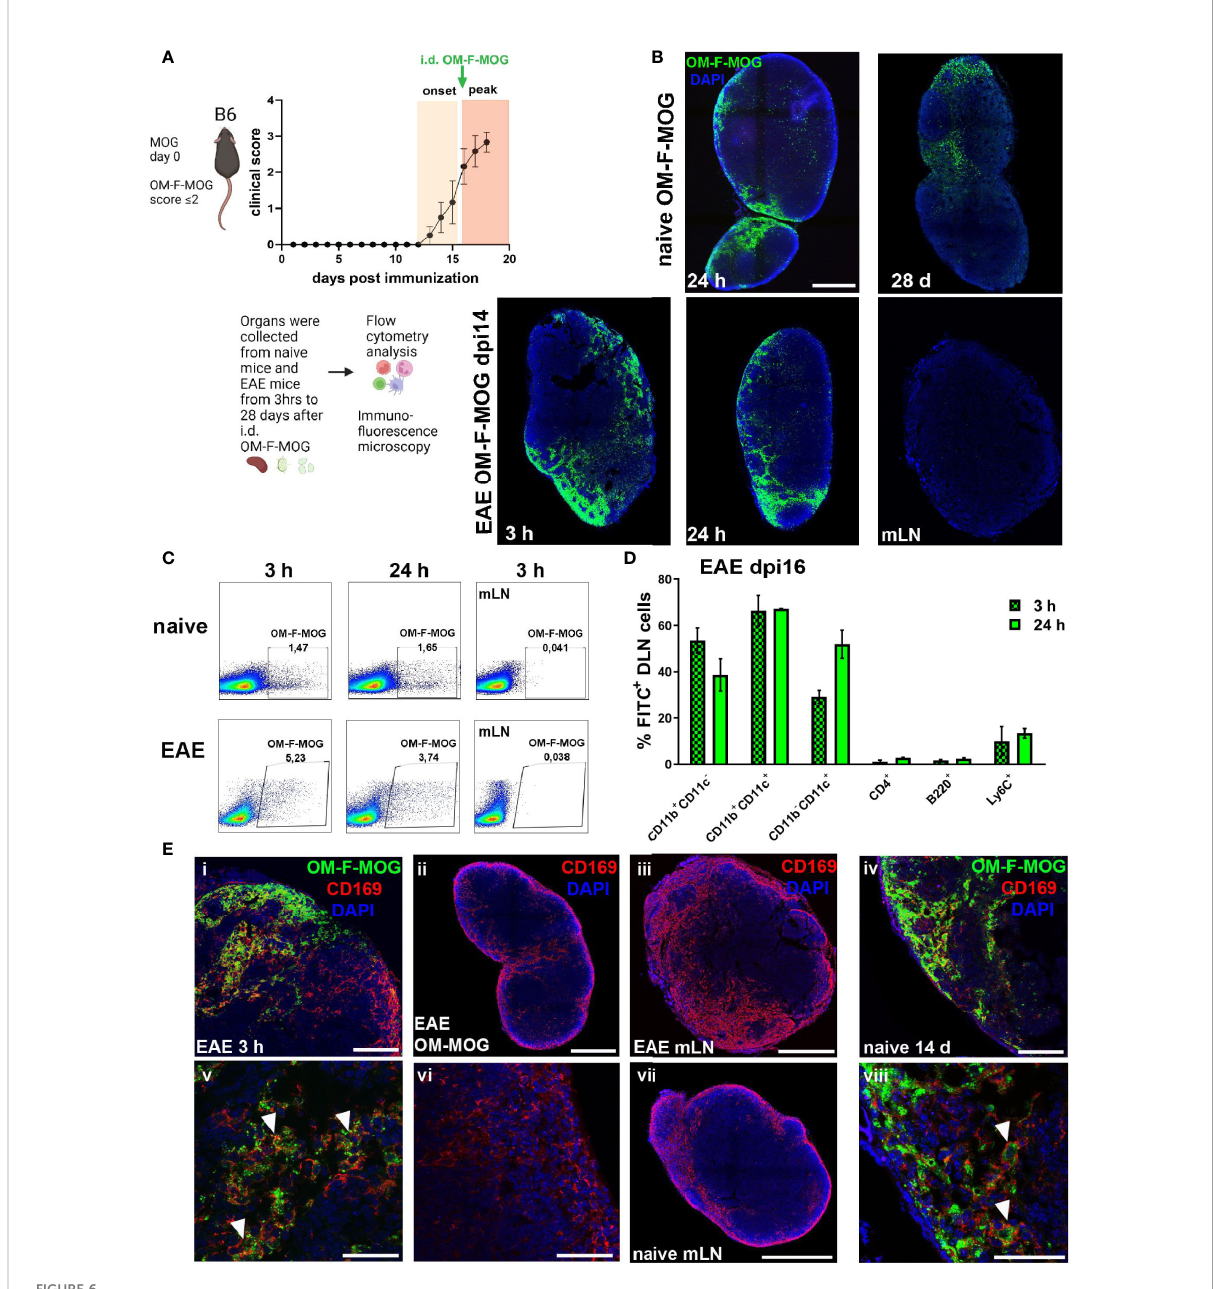
FIGURE 6 Soluble OM-MOG rapidly localizes to CD169 + subcapsular macrophages in the skin DLN: (A) Schematic representation of the overall experimental approach and the time point of injection of OM-F-MOG in the EAE mice. (B) Frozen sections of draining skin LN (DLN) and mesenteric LN (mLN) recovered from naïve (top row) and EAE mice at dpi 14 (bottom row), after a single i.d. injection of OM-F-MOG, showing the distribution of FITC fl uorescence (green) at the indicated time-points and counter-stained with DAPI (blue). Representative images are shown from 1 mouse (naïve) and 1 of 2 mice (EAE). Scale bar 500 m M; 10x objective. (C) Flow cytometry plots of DLN cells ( fi rst 2 panels in each row) and mLN cells (3 rd panels) recovered from naïve and EAE mice at dpi 16, after a single i.d. injection of OM-F-MOG, at the indicated time- points. Representative plots from 1 mouse (naïve) and 1 of 2 mice (EAE). (D) Proportions of FITC + cells in different cell populations of the DLN, recovered from EAE mice 3 h and 24 h after a single therapeutic i.d. injection of OM-F-MOG (n=2 mice/time point). (E) Frozen sections of DLN and mLN, as shown in (A) , immunostained with anti-CD169 (red) and counterstained with DAPI (blue). Tissues were collected from EAE mice at 3 h (i, iii, v) and 24 h (ii, vi), or naïve mice at 14 d (iv, vii, viii), after a single i.d. injection of OM-F-MOG or, as anti-CD169 immunostaining control, OM-MOG without FITC (ii, vi). Scale bars 500 m M, 10x objective (ii, iii, vii); 100 m M; 20x objective (i, iv); 50 m M; 63x objective (v, vi, viii). Representative images from 1 mouse (naïve) and 1 of 2 mice (EAE). Data are from two independent experiments, one for A, D (immunohistochemistry), and one for B, C ( fl ow